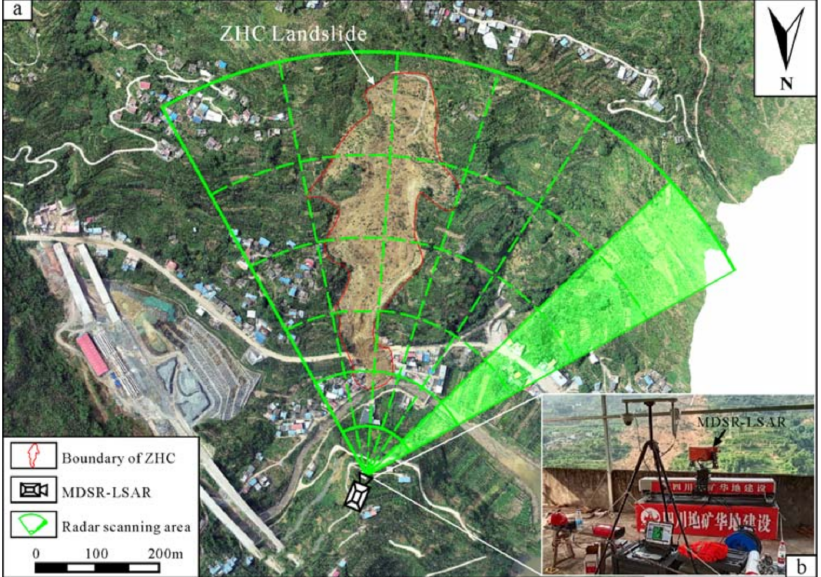
Figure 11. ( a ) Region of the in-site monitoring after the ZHC landslide. ( b ). The MDSR-LSAR instrument used for this